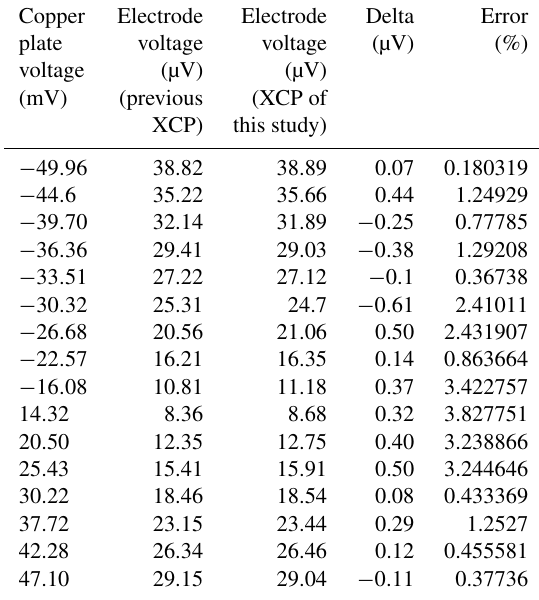
Table 3. Comparison of test